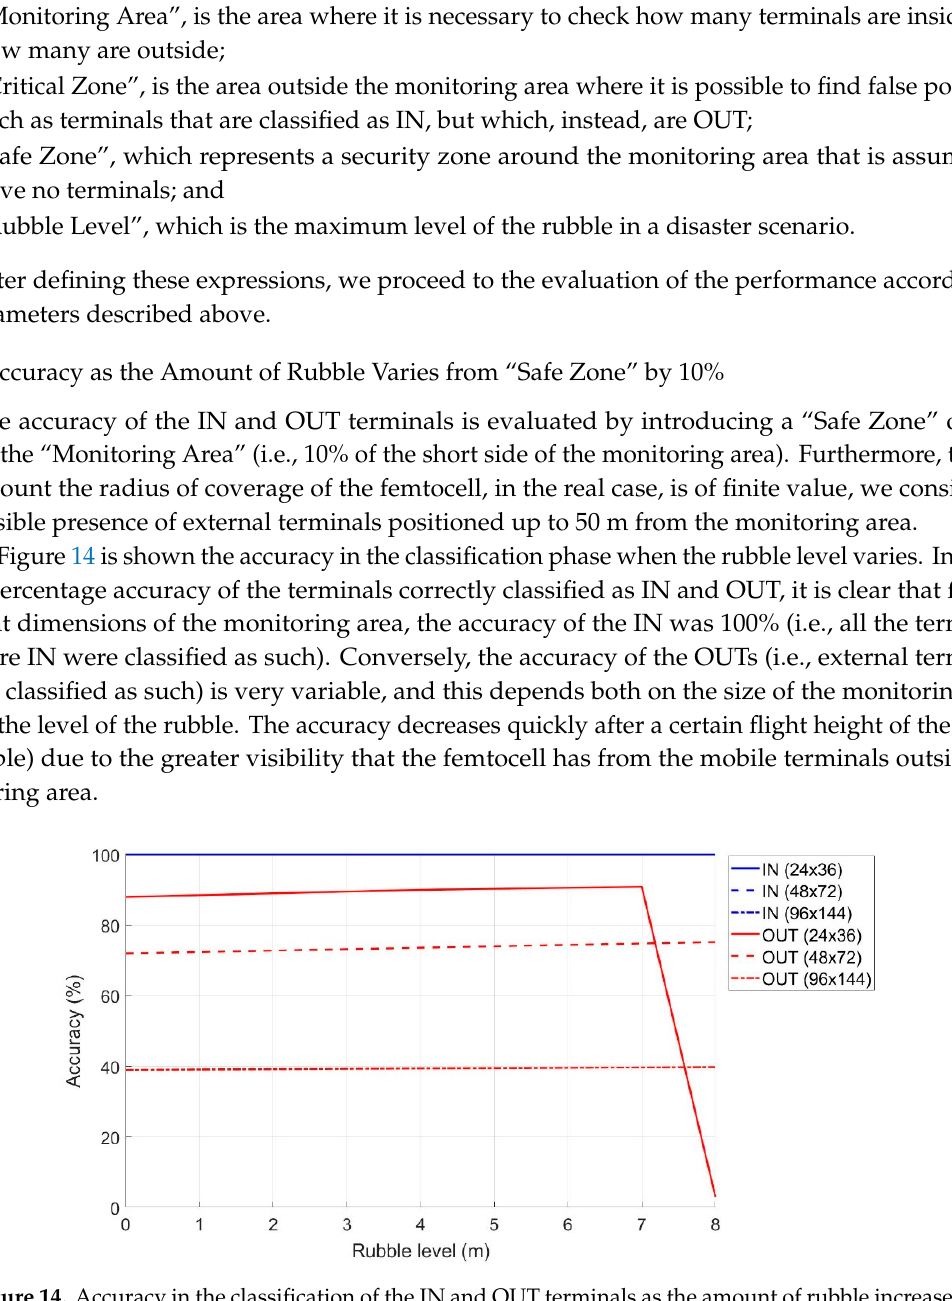
Figure 14. Accuracy in the classification of the IN and OUT terminals as the amount of rubble